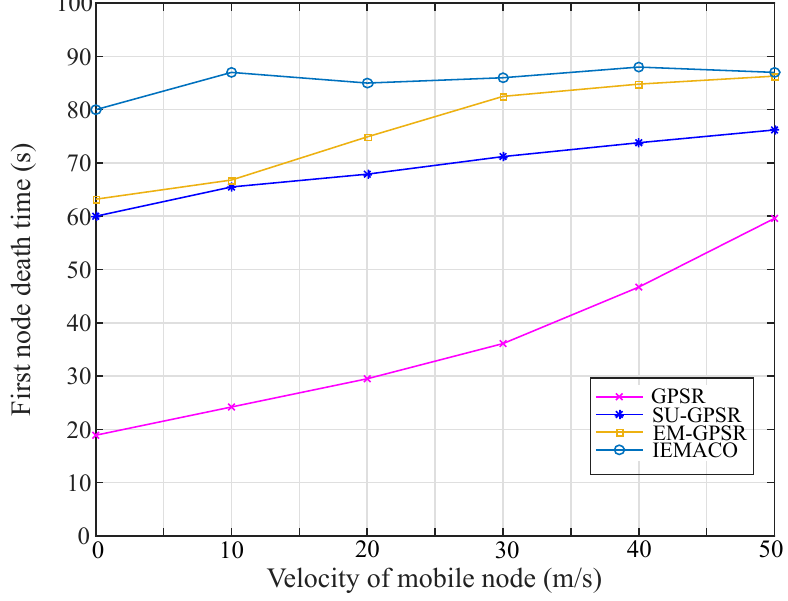
Figure 10. First node death time versus the velocity of a mobile